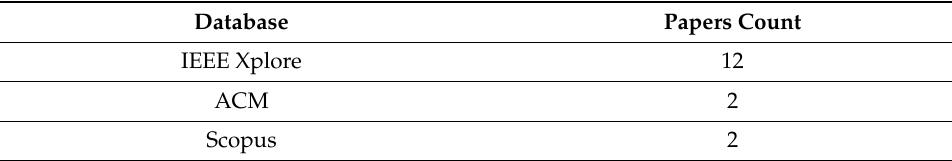
Table 1. Count of papers returned by databases.